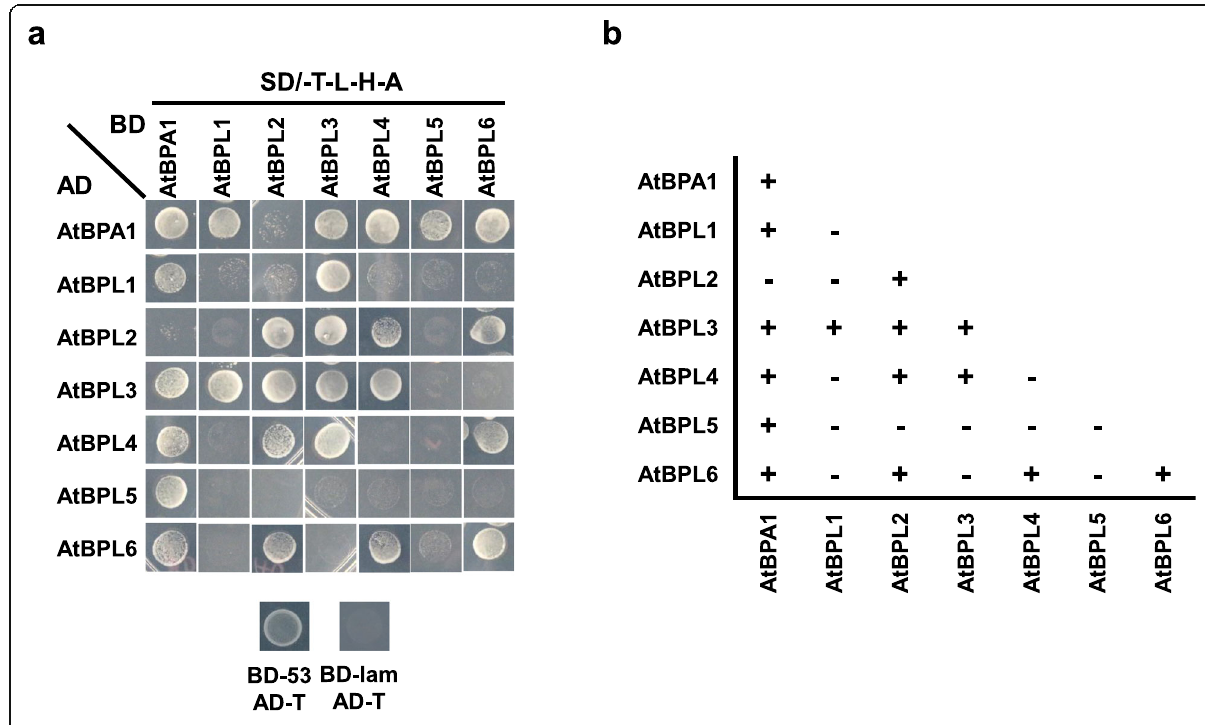
Fig. 6 Physical interactions between Arabidopsis BPAs. a Physical interactions between Arabidopsis BPAs revealed by Y2H assay. Arabidopsis BPA genes were cloned into the bait vector pGBKT7 (BD) and the prey vector pGADT7 (AD). The combination of BD-53 and AD-T was used as the positive control. BD-Lam and AD-T combination was used as the negative control. Yeast transformants were grown on selective medium (SD) lacking Tryptophan (T) and Leucine (L) and selected on SD lacking Tryptophan (T), Leucine (L), Histidine (H) and Adenine (A). Plates were photographed 3 days after inoculation. b Summary of the interactions. “ + ” represents interaction. “ - ” represents no